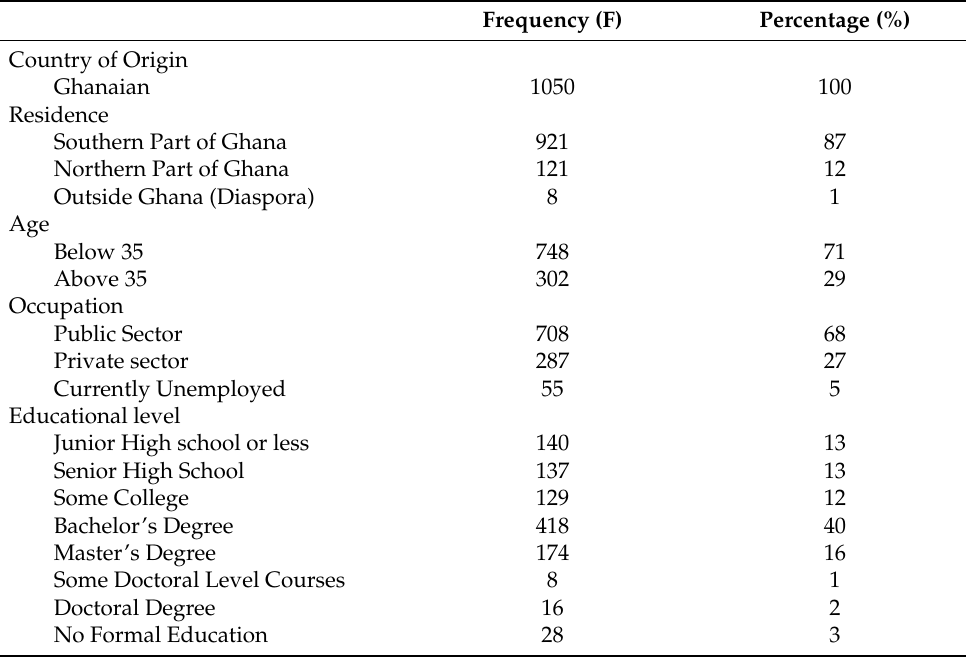
Table 1. Socio-Demographic Characteristics of Respondents (n =